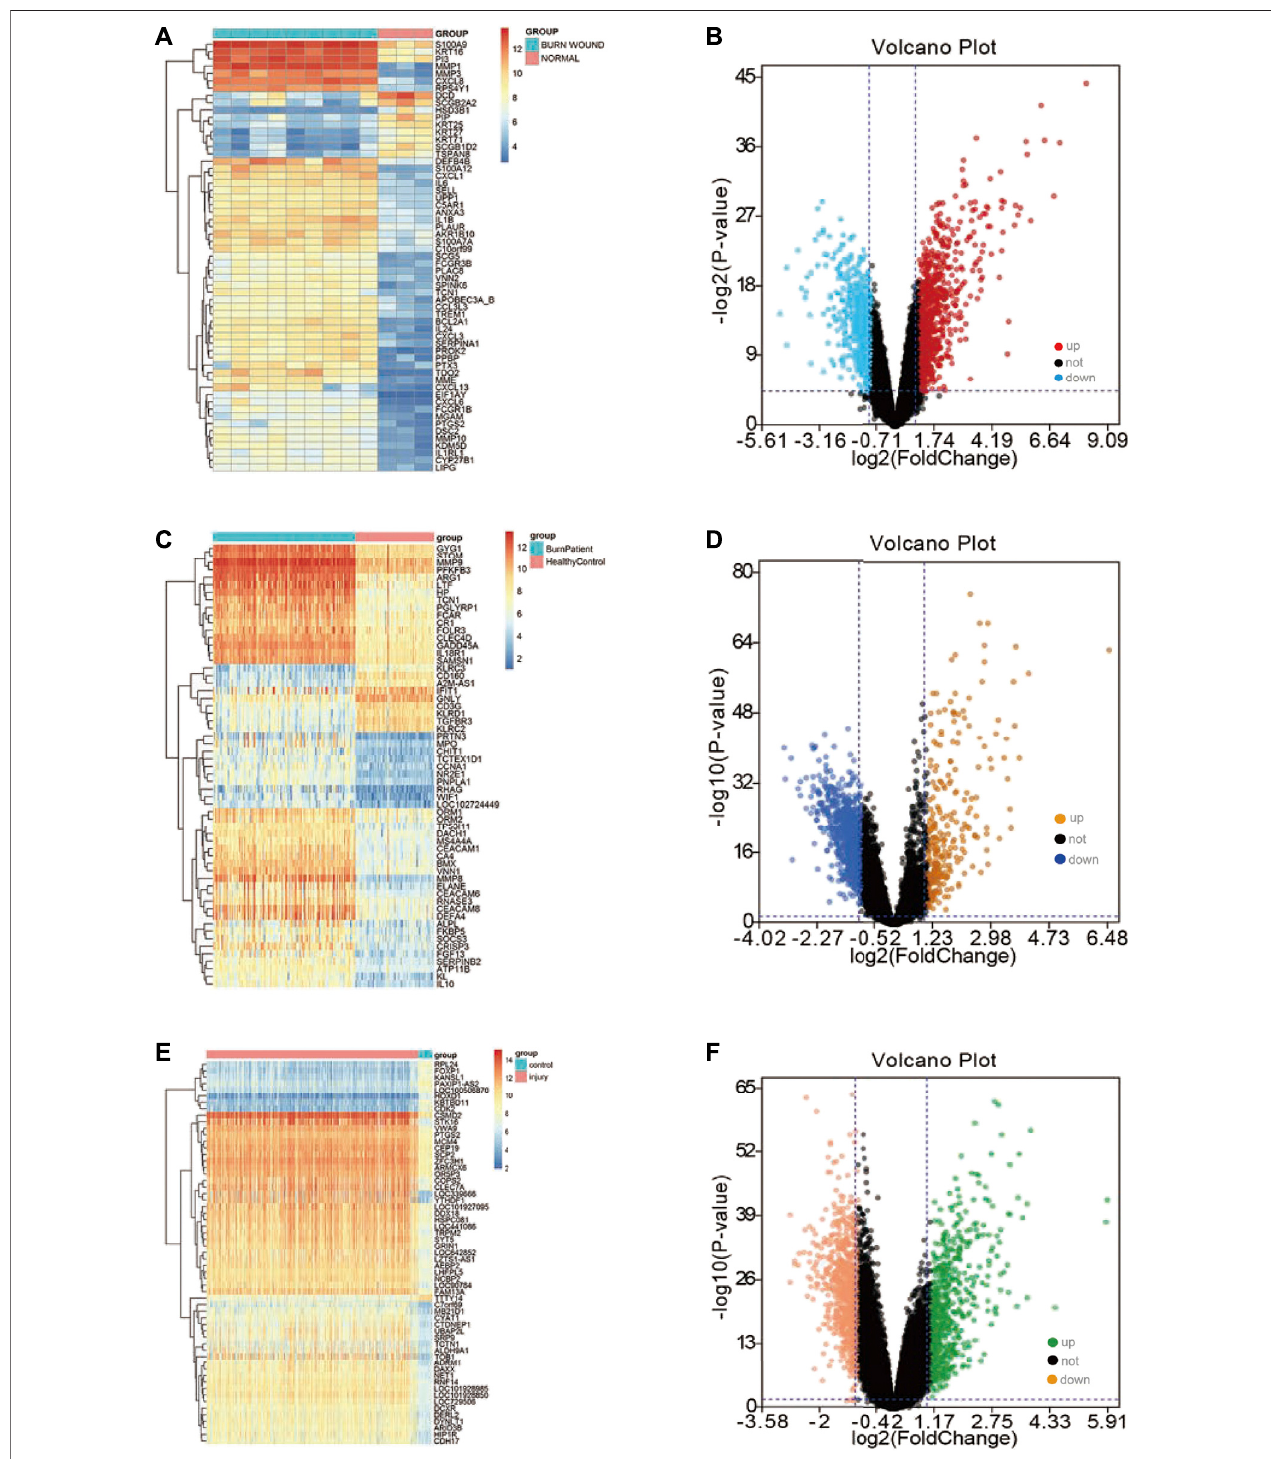
FIGURE2| Differential expression analysisinthreedatasets. (A) Thegeneexpression heatmap ofimportantDEGs intheGSE8056dataset; (B) thevolcanoplotof thedifferentialexpressionanalysisintheGSE8056dataset; (C) thegeneexpressionheatmapofimportantDEGsintheGSE19743dataset; (D) volcanoplotofdifferential expression analysis in GSE19743 dataset; (E) the gene expression heatmap of important DEGs in the GSE37069 dataset; (F) volcano plot of differential expression analysis in GSE37069 dataset.